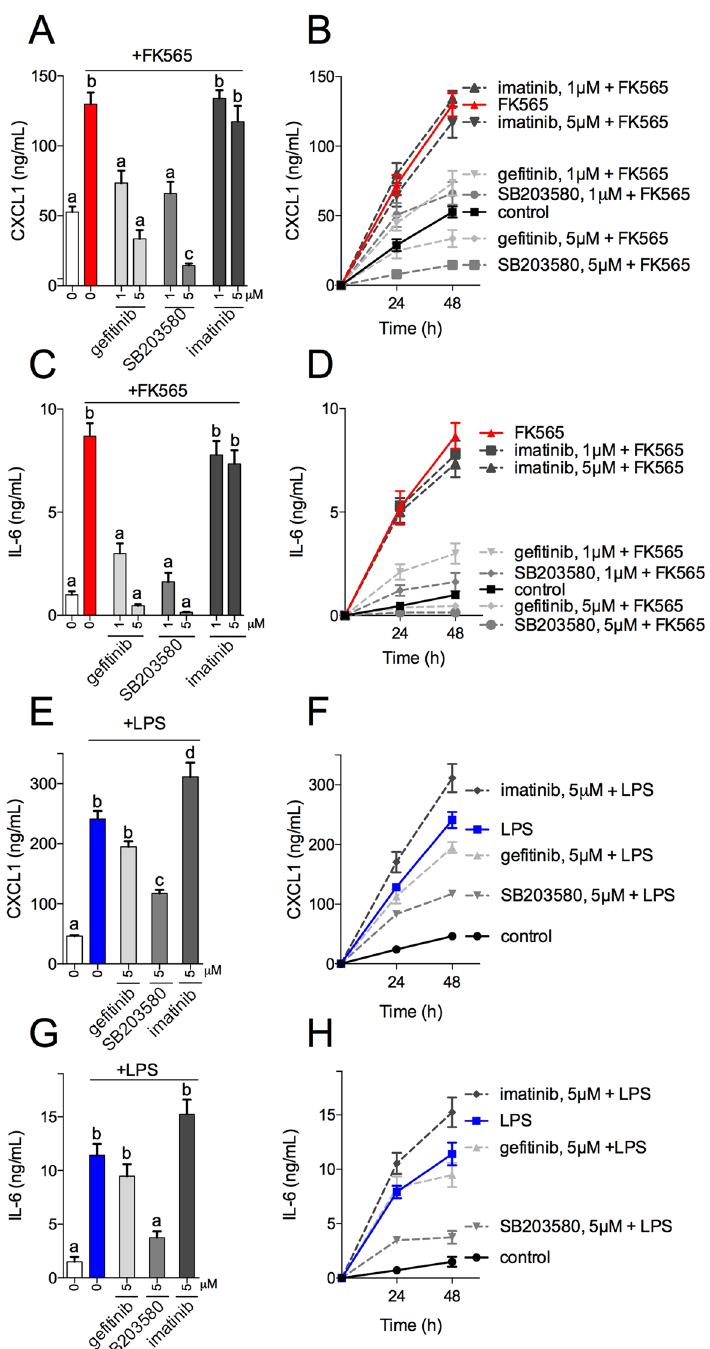
Figure 2. Selected TKIs inhibit cytokine responses in adipocytes induced by bacterial cell wall-mediated components, but not endotoxin. Levels of Cxcl1 released from 3T3-L1 adipocytes after stimulation with the Nod1 ligand FK565 (10 μ g/mL) for 48 h and pre-incubated for 1 h with 1 or 5 μ M of the TKIs gefitinib, SB203580 or imatinib ( A ) n = 6. Time course of FK565-stimulated Cxcl1 secretion in 3T3-L1 adipocytes ( B ) n = 6. Levels of Il6 released from 3T3-L1 adipocytes after stimulation with the Nod1 ligand FK565 (10 μ g/mL) for 48 h and pre-incubated for 1 h with 1 or 5 μ M of the TKIs gefitinib, SB203580 or imatinib ( C ) n = 5. Time course of FK565-stimulated Il6 secretion in 3T3-L1 adipocytes ( D ) n = 5. Levels of Cxcl1 released from 3T3- L1 adipocytes after stimulation with the Tlr4 ligand LPS (0.5 μ g/mL) for 48 h and pre-incubated for 1 h with 1 or 5 μ M of the TKIs gefitinib, SB203580 or imatinib ( E ) n = 6. Time course of LPS-stimulated Cxcl1 secretion in 3T3-L1 adipocytes ( F ) n = 6. Levels of Il6 released from 3T3-L1 adipocytes after stimulation with the Tlr4 ligand LPS (0.5 μ g/mL) for 48 h and pre-incubated for 1 h with 1 or 5 μ M of the TKIs gefitinib, SB203580 or imatinib ( G ) n = 5. Time course of LPS-stimulated Il-6 secretion in 3T3-L1 adipocytes ( H ) n = 5. Values are mean ± SEM. Different letters assigned to each condition (a, b, c) denote statistical differences between groups (p <